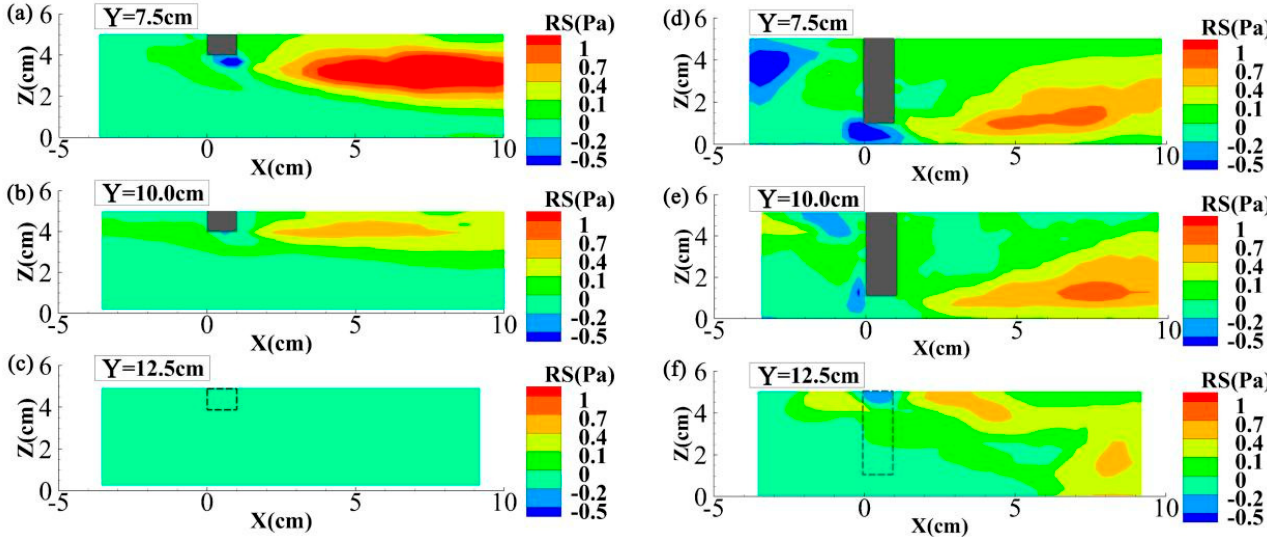
Figure 10. Distributions of the <u’w’> component of Reynolds stress at longitudinal sections ( a ) Y = 7.5 cm, ( b ) Y = 10.0 cm, ( c ) Y = 12.5 cm in Case 3 (on the left) and at longitudinal sections ( d ) Y = 7.5 cm, ( e ) Y = 10.0 cm, ( f ) Y = 12.5 cm in Case 4 (on the right). The grey areas in subfigures ( a ), ( b ), ( d ) and ( e ) demonstrate the floating dike, and the dotted lines in subfigures ( c ) and ( f ) indicate the location of floating dike in the coordinate system.